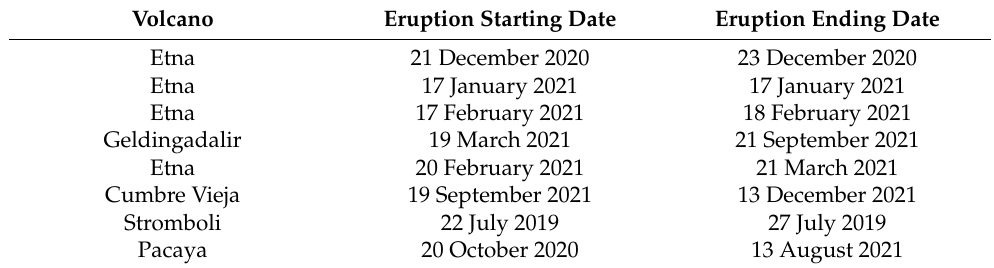
Table 1. Volcanoes investigated with the date of beginning and ending of the eruptive events.